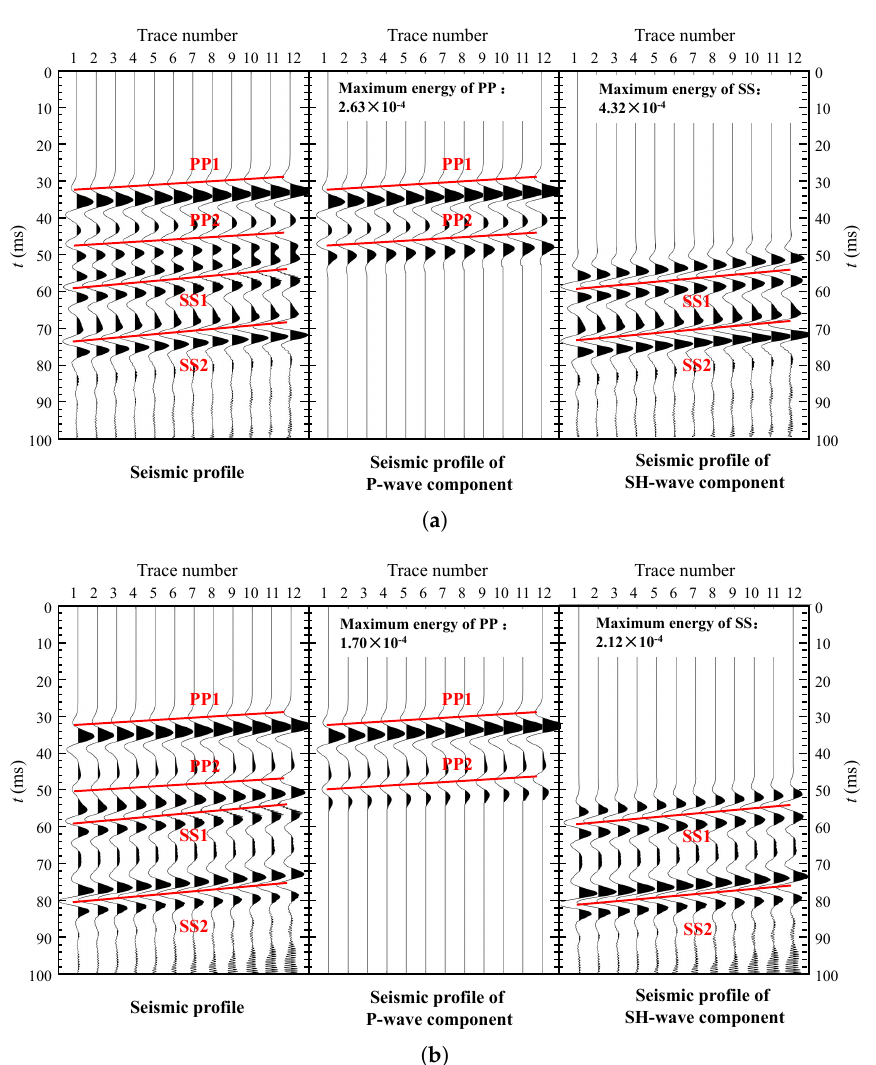
Figure 9. The seismic profile of the upper and lower wall lines of the wedge fault. ( a ) The seismic profile of the lower wall lines. ( b ) The seismic profile of the upper wall